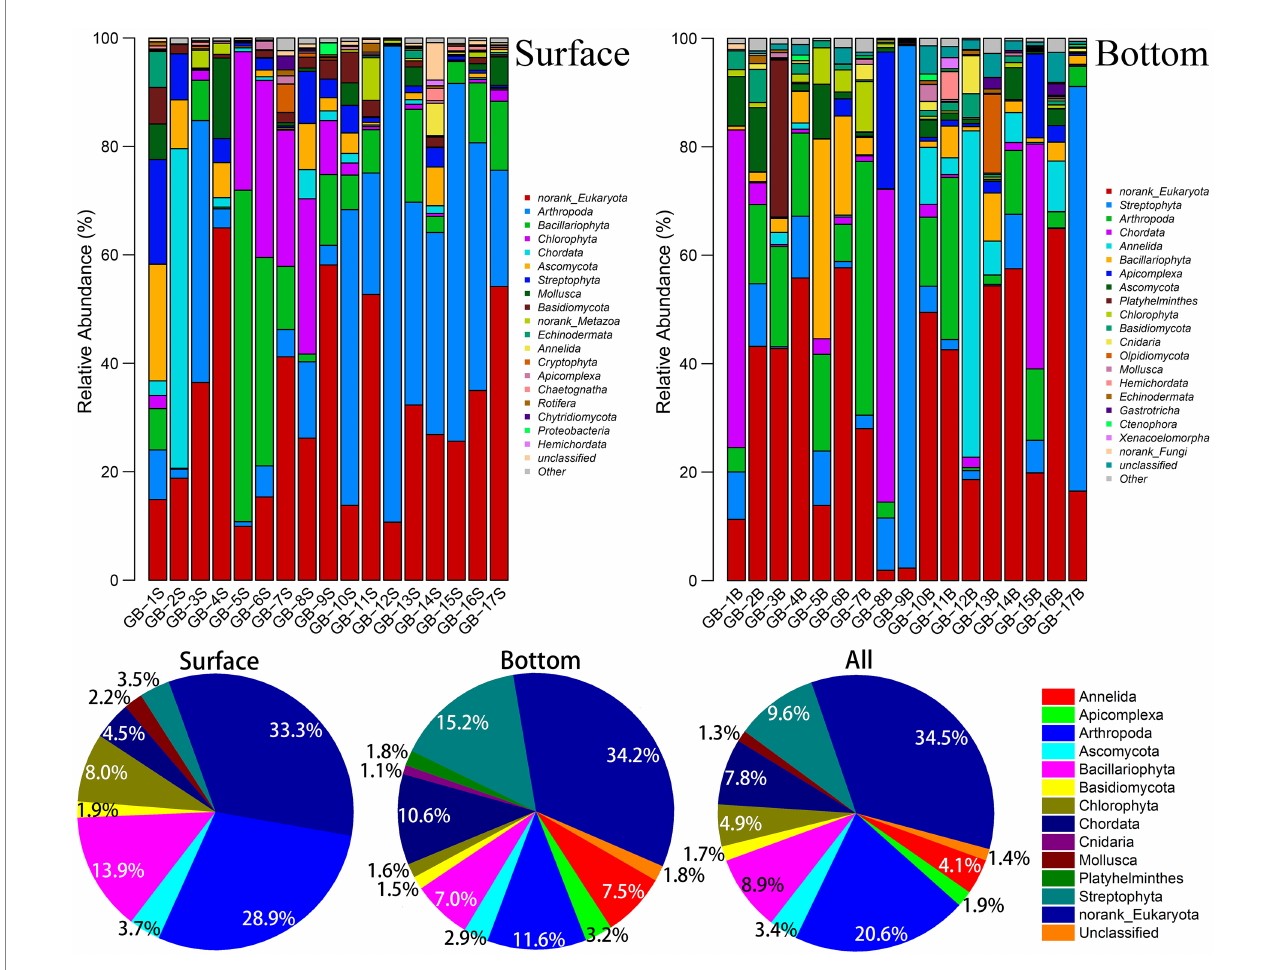
FIGURE 2 Abundance of dominant eukaryotic plankton at phylum level. The dominant species in the bar chart were those whose OTU number in each site were more than 1%; The dominant species in the pie chart are those whose OTU are more than 1% in the surface, bottom, or